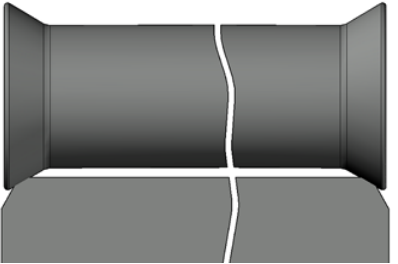
Figure 4. Schematic diagram of vertical rolling at the chamfered slab corner.